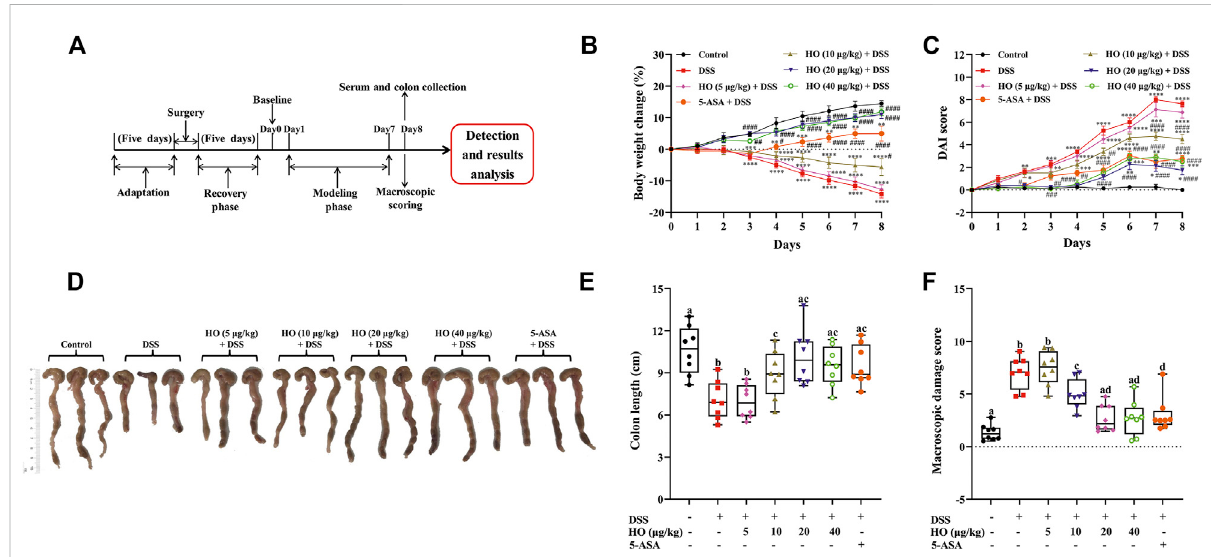
FIGURE 1 Effects of human opiorphin treatment on macroscopic colonic damage in DSS-induced colitis in mice. (A) Experimental design in this experiment. (B) Body weight change. The body weight change was calculated as the percentage of weight gain or loss in relation to baseline weight for each mouse. (C) DAI score. (D) Macroscopic images of colons. (E) Colon length. (F) Macroscopic damage score. The data are expressed as mean ± S.E.M. ( n = 8). * p < 0.01, ** p < 0.01, *** p < 0.005, **** p < 0.0001 vs. control group, and # p < 0.05, ## p < 0.01, ### p < 0.005, #### p